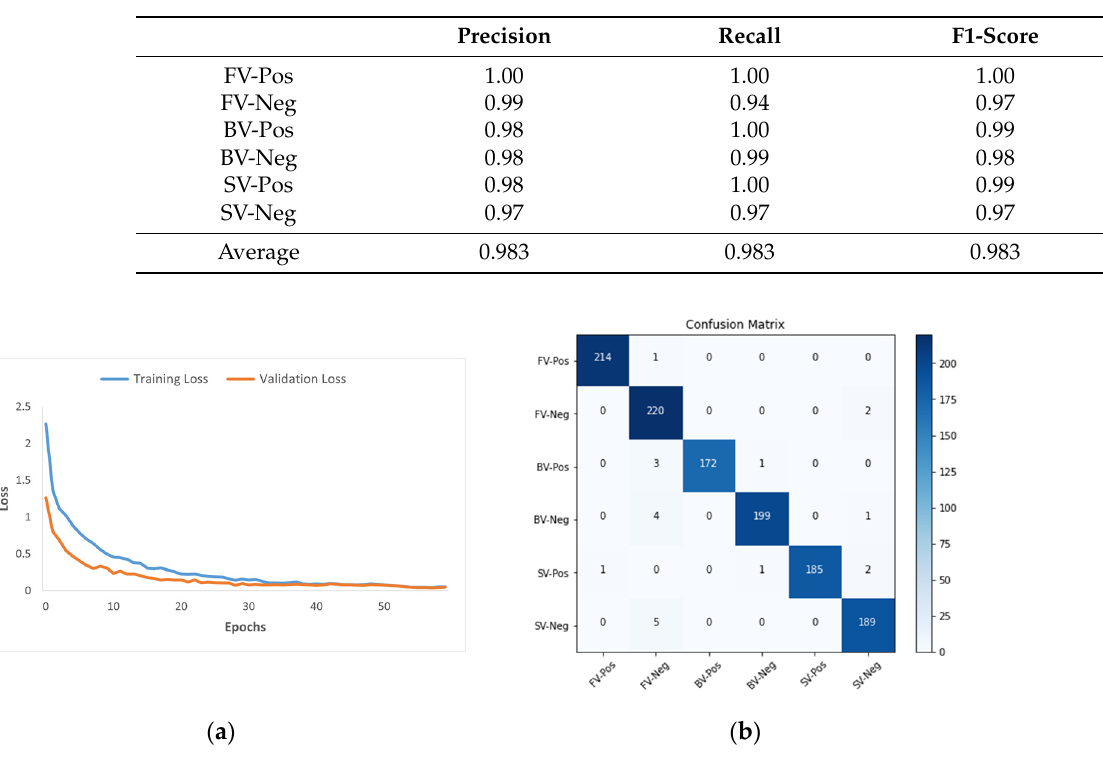
Figure 11. The loss curve and confusion matrix of the second experiment on the PETA dataset: ( a ) The loss curve, ( b ) the confusion matrix.